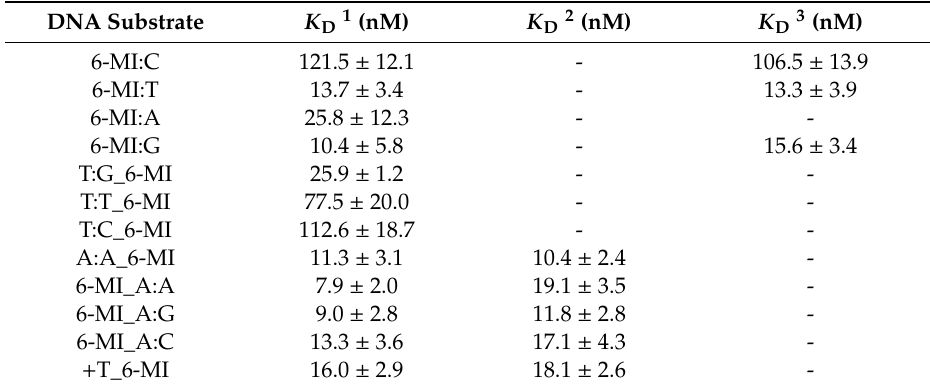
Table 1. Equilibrium binding a ffi nity of S. cerevisiae Msh2-Msh6 with mismatched duplex DNA measured by fluorescence